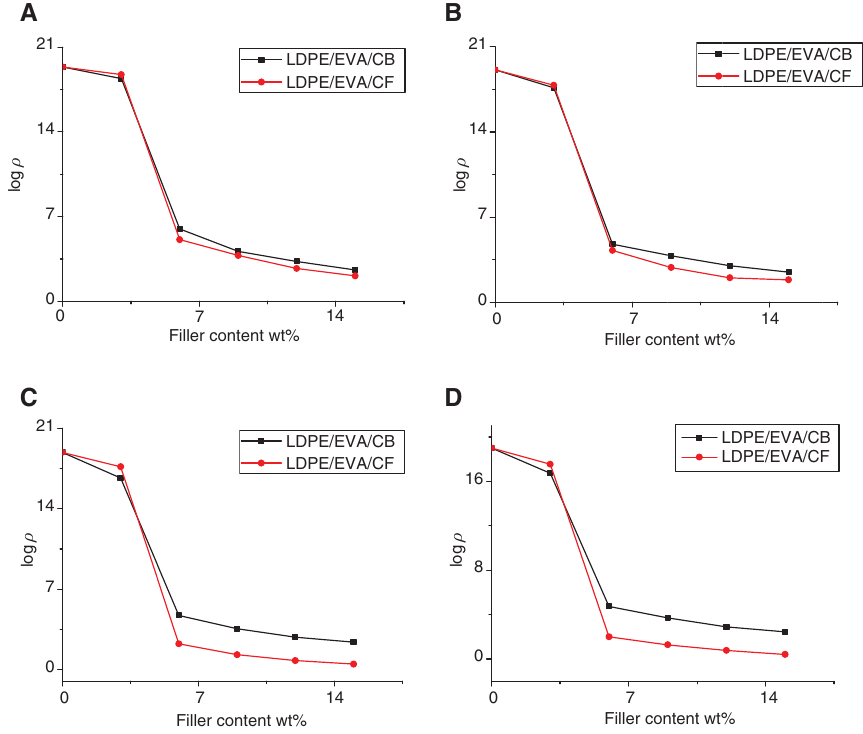
Figure 6: Contrast of LDPE/EVA/CB and LDPE/EVA/CF composites resistivity with different ratios of LDPE to EVA. (A) LDPE/EVA 100/0, (B) LDPE/EVA 80/20, (C) LDPE/EVA 60/40, (D)LDPE/EVA